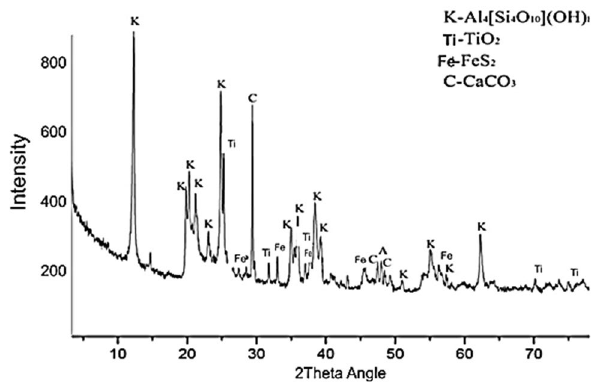
Fig. 2 XRD diffraction of